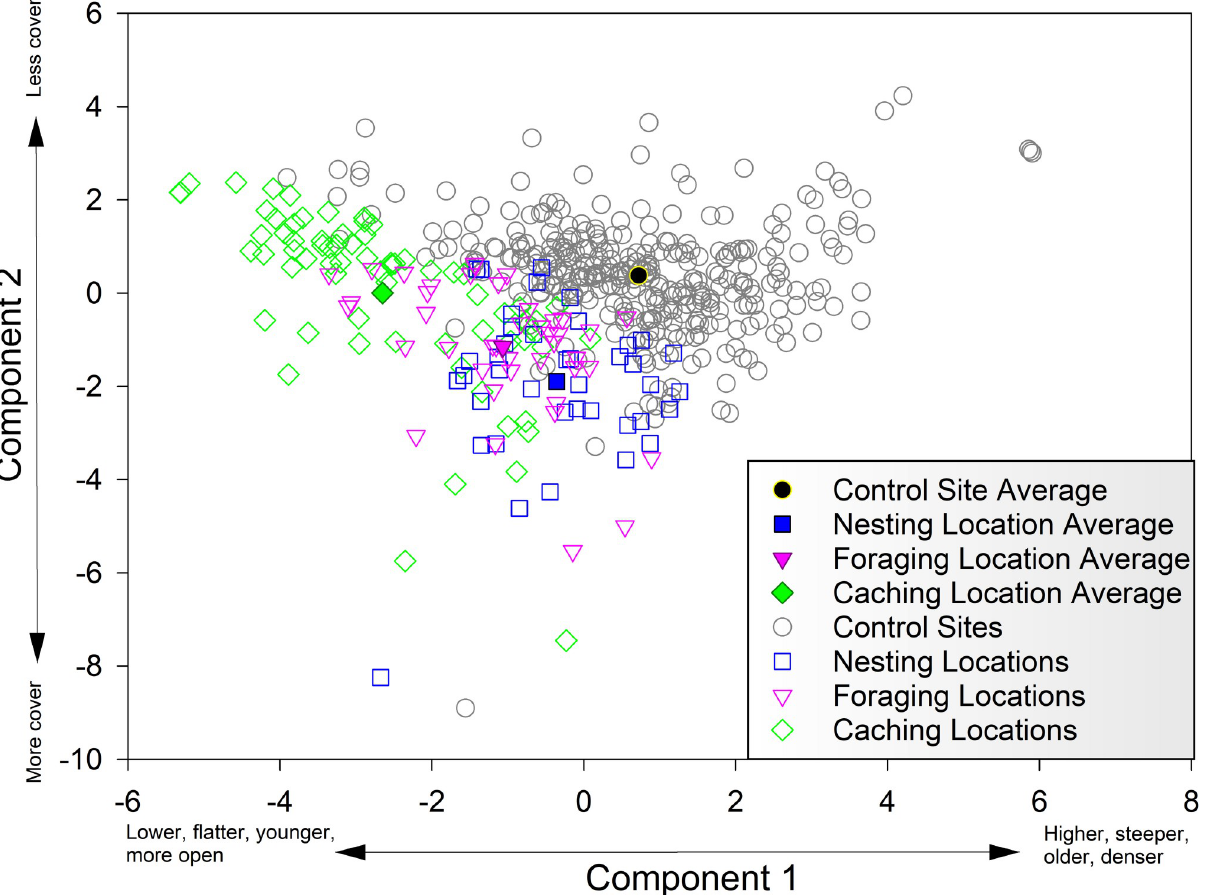
Fig 4. Ordination plot. Pinyon Jay locations by behavior type and control sites plotted along the first two PCA axes (see Table 4 for axis loadings). Mean values for each Pinyon Jay behavior type and for control sites are depicted as solid symbols, and individual data records are open symbols.